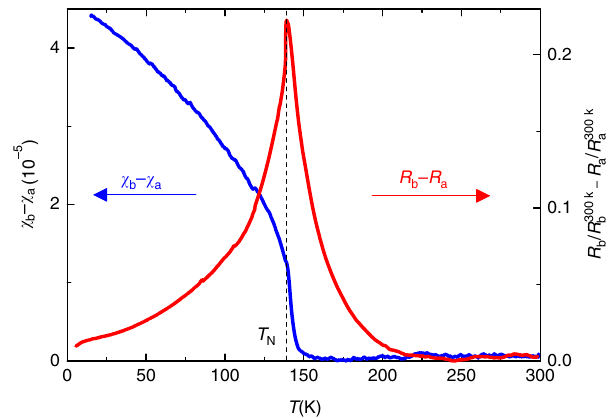
Fig. 3 Comparison between in-plane resistance anisotropy and susceptibility anisotropy. Temperature dependence of in-plane resistance and susceptibility anisotropies, which demostates that these two anisotropies do not scale with each